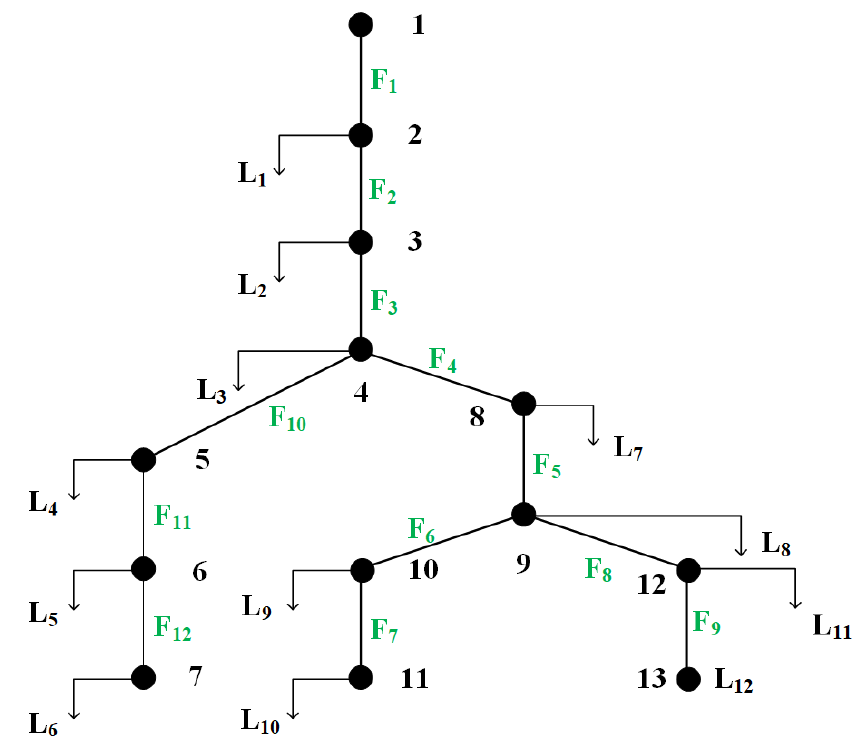
Figure 3. 13-bus RDS